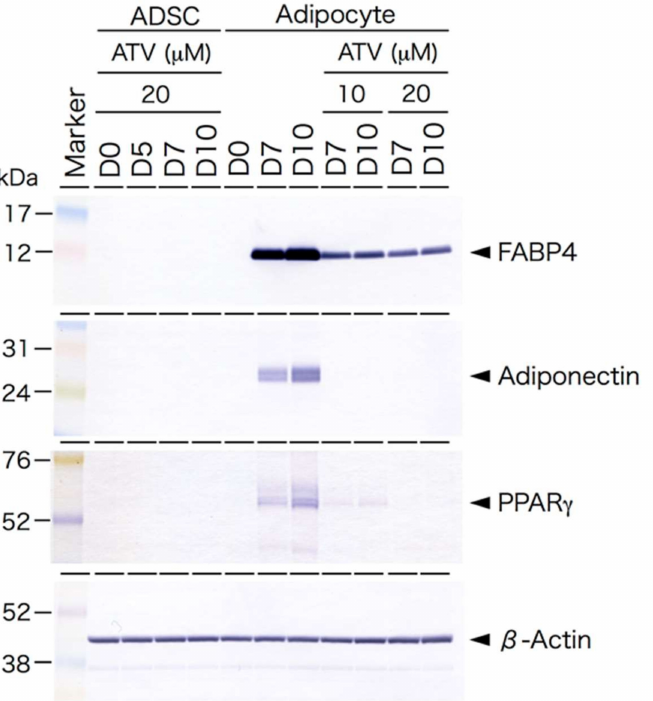
Figure 3. Western blot analysis of adipogenesis-related proteins ADSCs cultured in a serum-free medium, treated with 20 µ M ATV for the indicated time (ADSC). D0 indicates the day when ATV was administrated. ADSCs, cultured in serum-free medium until they reached confluence, were cultured in adipogenic differentiation medium for the indicated time with or without ATV at 10 µ M or 20 µ M for the indicated time (adipocyte). D0 indicates the day when the medium was changed to differentiation medium and ATV was concurrently added. Protein samples (8 or 16 µ g) were electrophoresed on SDS-polyacrylamide gel, electrophoretically transferred to a polyvinyl difluoride membrane, and the membrane was incubated with the indicated primary antibodies. PPAR γ , peroxisome proliferator activated receptor- γ